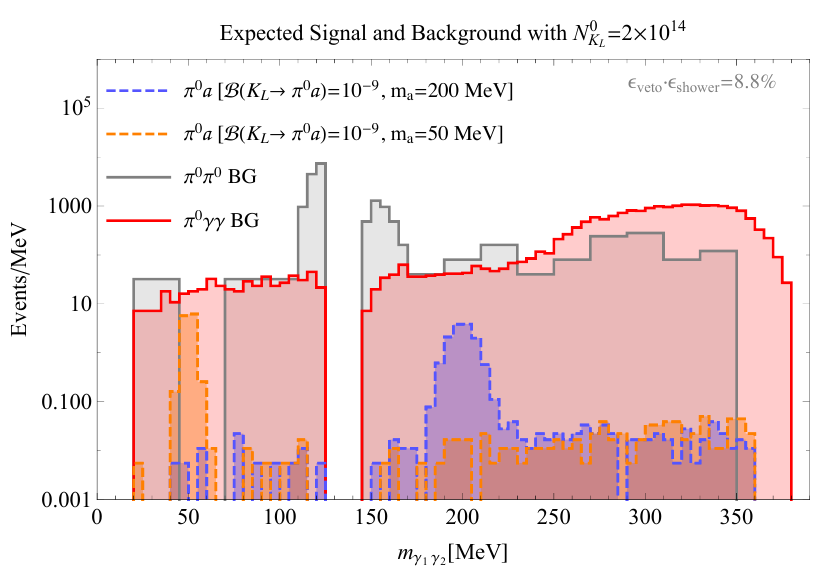
Figure 3 . The expected background distribution after cuts with N 0 the distributions for the signal of a ALP with m a = 50 ; 200 MeV and BR( K L ! (cid:25)a ! 4 (cid:13) ) = 10 (cid:0) 9 are also shown. We use a larger bin size for the (cid:25) 0 (cid:25) 0 background except near the pion mass due to the poor MC statistics of the remaining events. For this (cid:12)gure, we also include the e(cid:14)ciencies of veto and shower cut ( (cid:15) veto = 17% and (cid:15) shower =